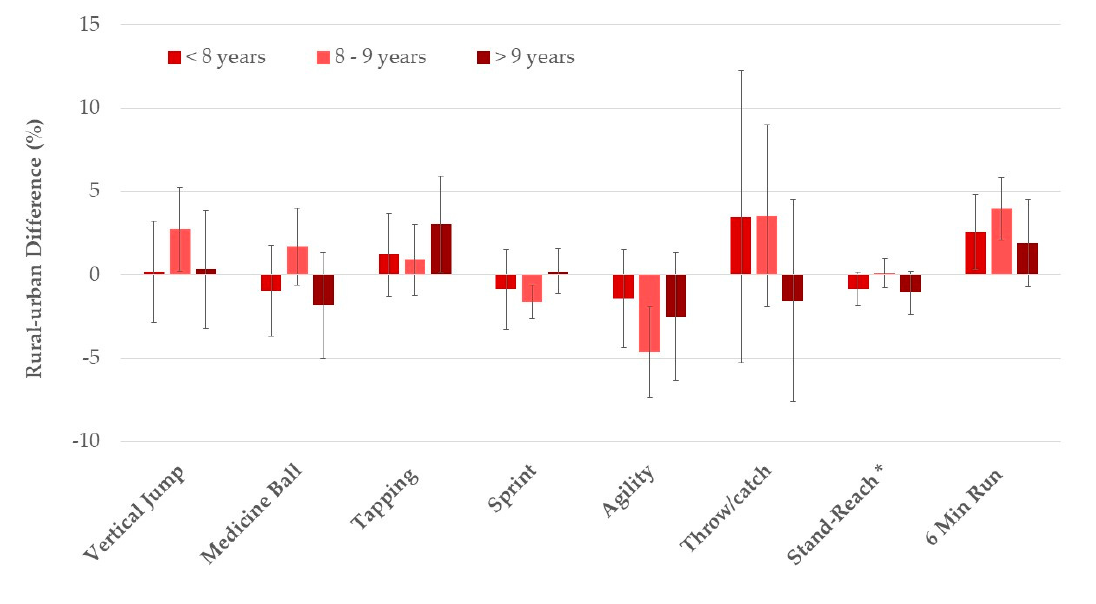
Figure 3. Rural–urban differences by age group in overweight/obese children. Values are mean differences, adjusted for sex with 95% CI.